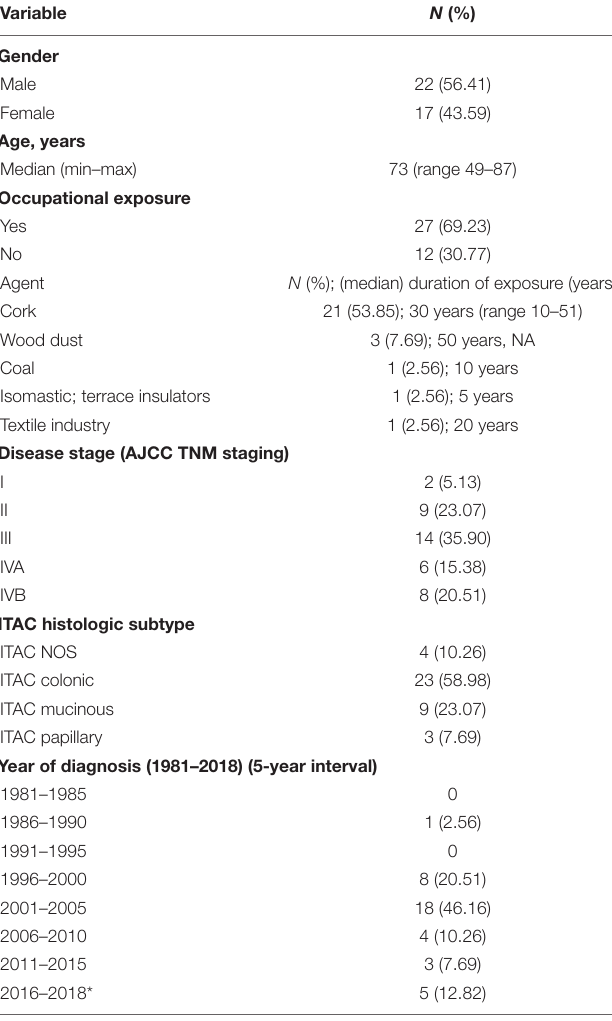
TABLE 1 | Clinical and demographic characteristics at diagnosis and exposure